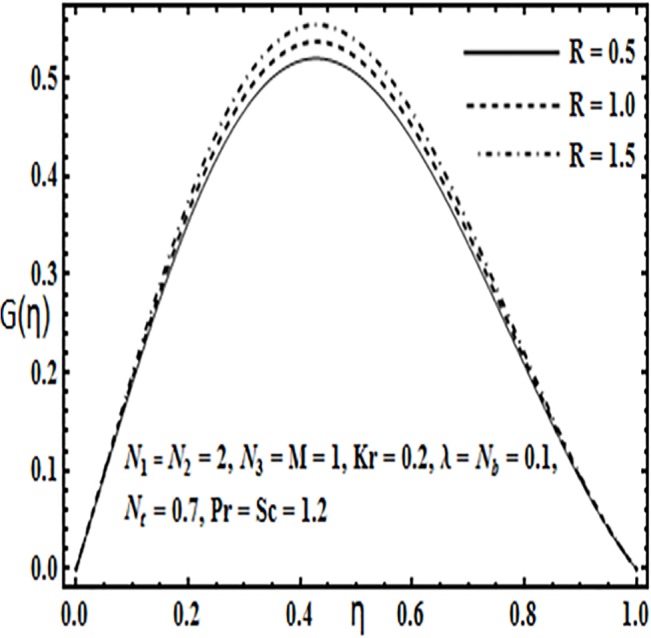
Effect of R on G(η).